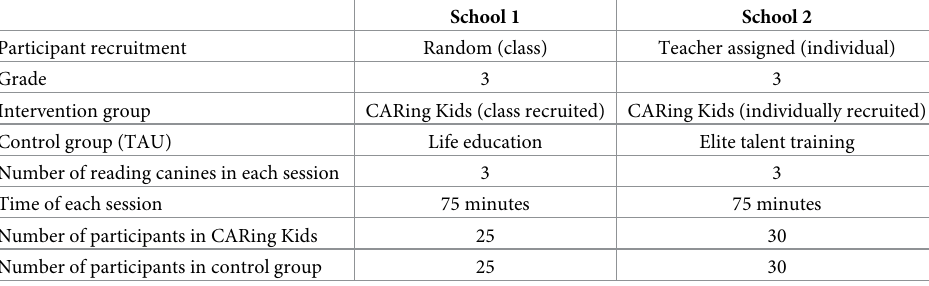
Table 1. Comparison of implementation characteristics of the CARing Kids in two